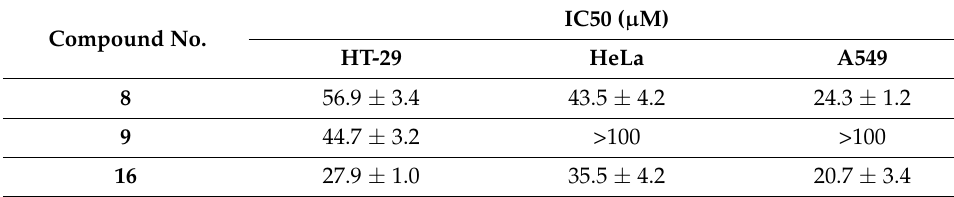
Table 4. IC 50 values of compounds 8 , 9 , and 16 on HT-29 , HeLa, and A549 . Compound